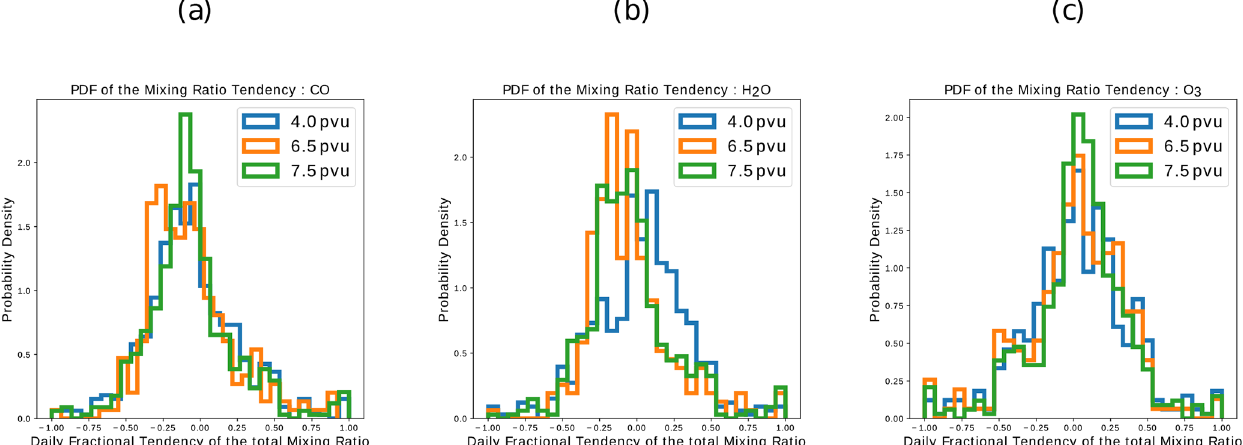
Figure 13. PDFs of the daily tendencies of the mixing ratios averaged within ASMA-related PV cutoffs. The tendencies – changes in mixing ratio per day – were normalized to the minimum–maximum mixing ratio range of each cascade. Only cascades with lifetimes of 3d or longer are